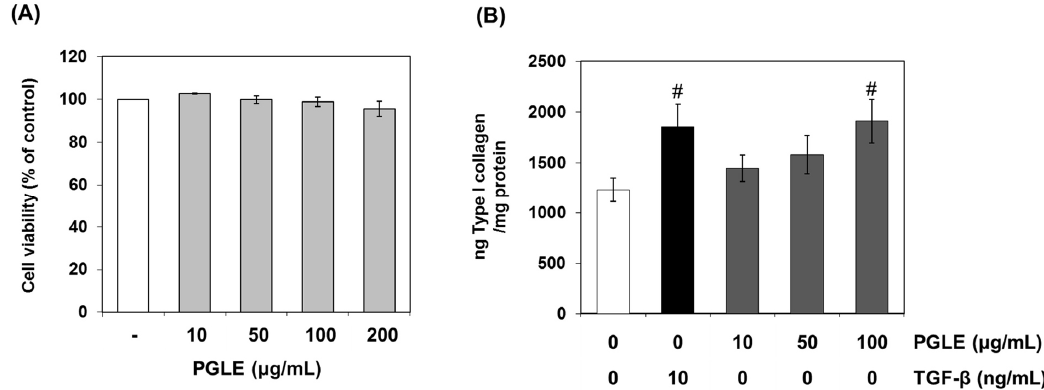
Figure 2. Effects of PGLE on collagen synthesis in human dermal fibroblast. Human dermal fibroblasts were cultured in 24-well plates. Human dermal fibroblasts were treated with or without transforming growth factor- β (TGF- β ) and/or PGLE at the indicated concentrations for 48 h at 37 °C. ( A ) Cell viability was measured by MTT assay; ( B ) The culture supernatants were harvested and measured with a sandwich immunoassay kit. Data are mean ± standard deviation. # p < 0.01 compared with the vehicle-treated group ( n = 3). The results were confirmed by five independent experiments.